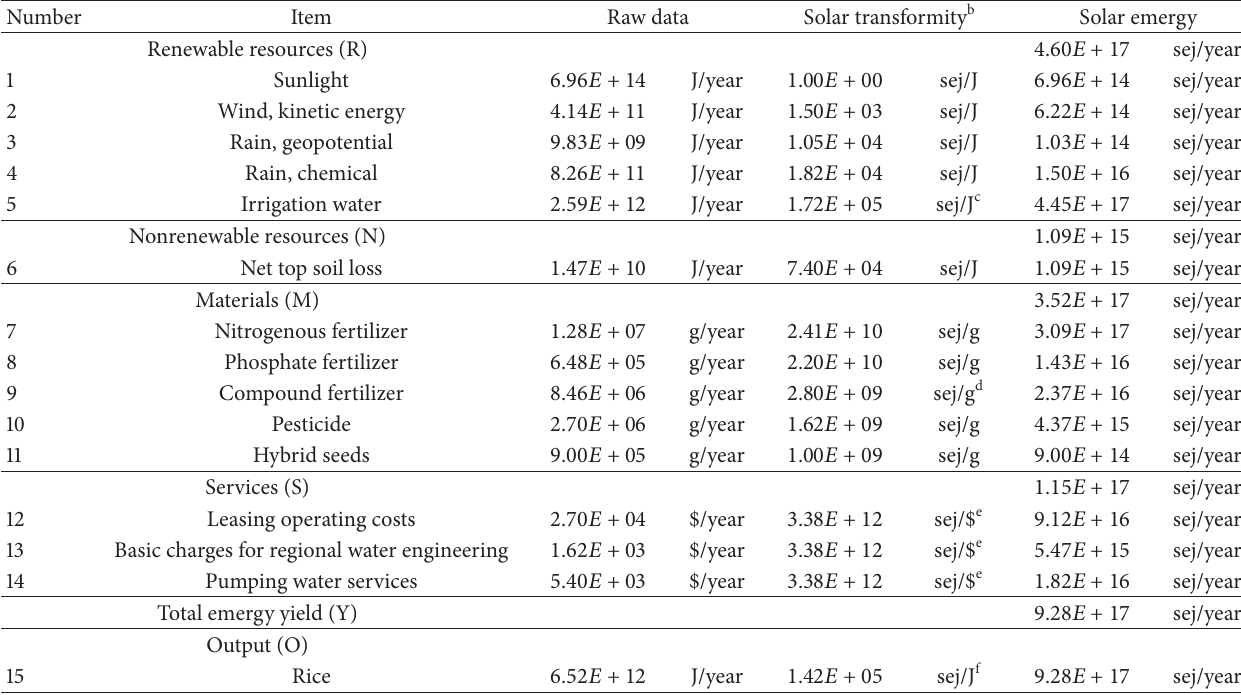
Table 3: Emergy evaluation of irrigated agriculture system a